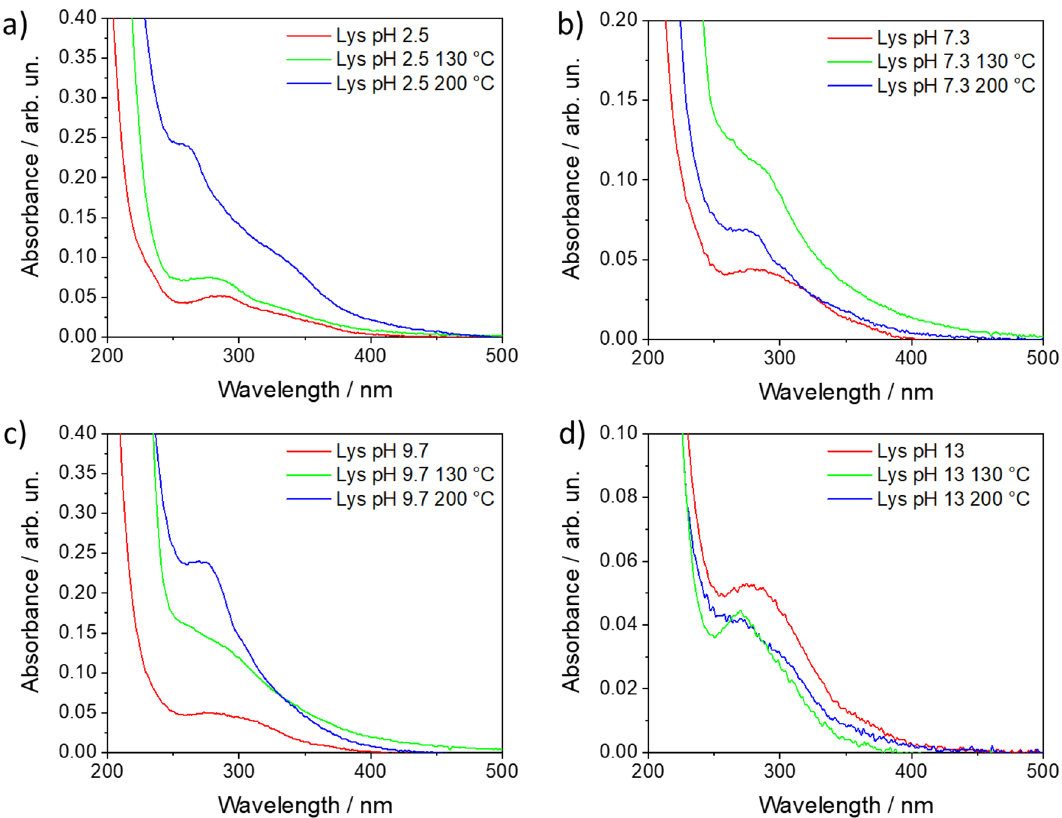
Figure 2. UV–Vis absorption spectra in the 200–500 nm range of l-lysine at pH 2.5 ( a ), 7.3 ( b ), 9.7 ( c ), and 13 ( d ). The red, green, and blue curves show the absorption spectra of the as-prepared aqueous solution, and after hydrothermal treatment at 130 and 200 °C, respectively. The concentration of l-lysine in the precursor solution was 0.87